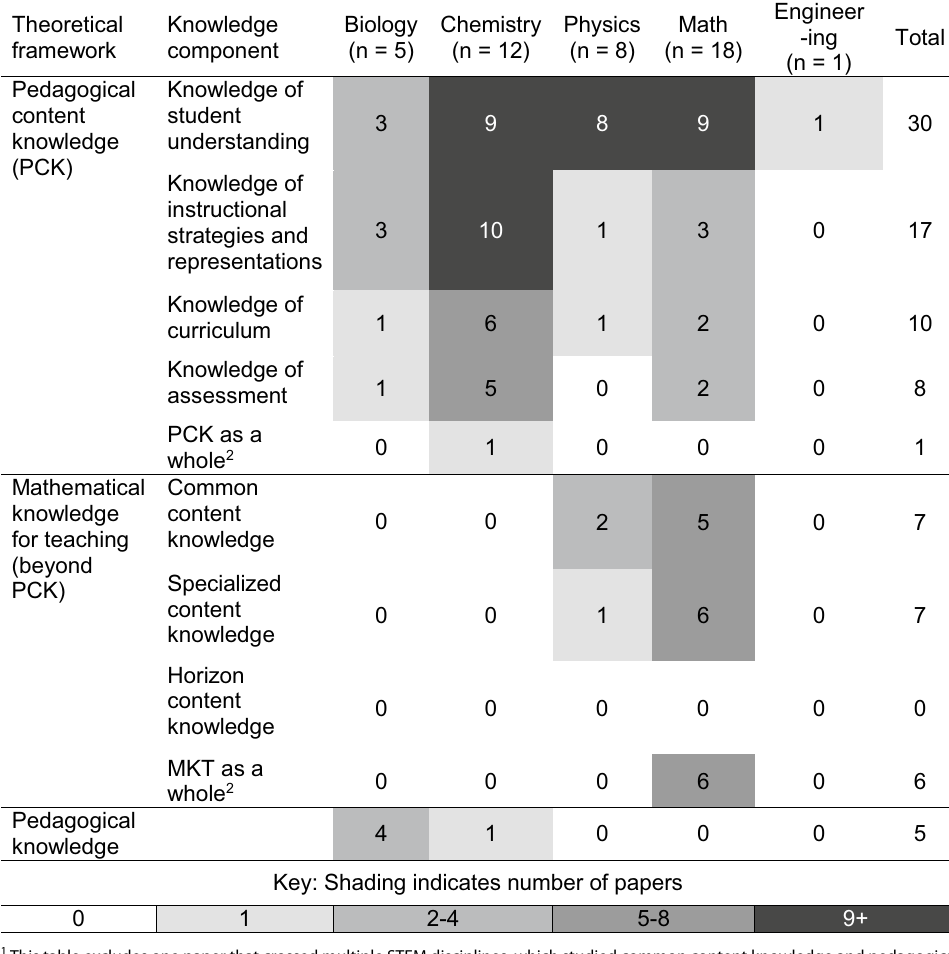
Table 4. Number of papers ( n